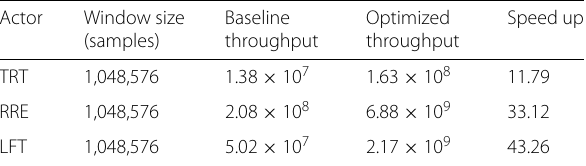
Table 3 Adaptation overhead in gapless jitter